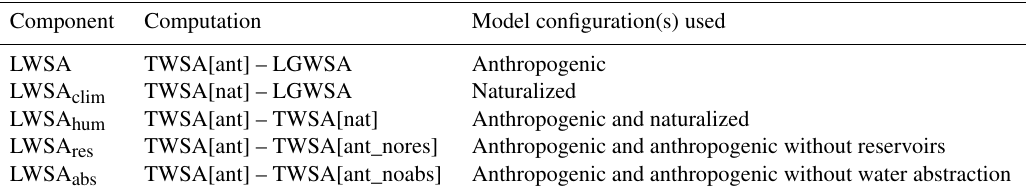
Table 2. Overview of how the TWSA mass budget components were calculated using the integrated WaterGAP variants. TWSA[ant], TWSA[nat], TWSA[ant_nores] and TWSA[ant_noabs] were computed under the anthropogenic, naturalized, anthropogenic without reser- voirs and anthropogenic without water abstraction configurations, respectively. The LGWSA remains